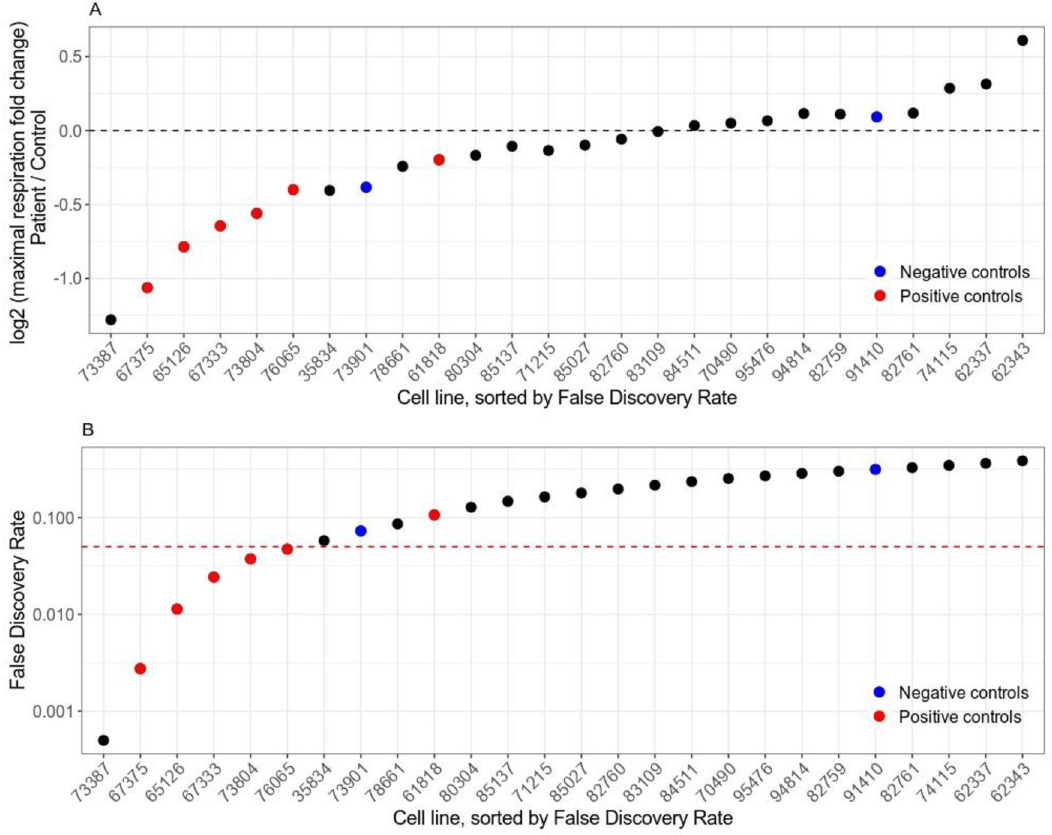
Fig 3. Maximal respiration change patient vs. control on multiple plates. (A) average log2 fold change (y-axis) of maximal respiration of all cell lines repeated across plates (x-axis) and their respective controls, sorted by the False Discovery Rate (FDR). Red and blue dots represent positive and negative controls, respectively. (B) similar to (A), but depicting FDR. Red dashed line represents FDR = 0.05.